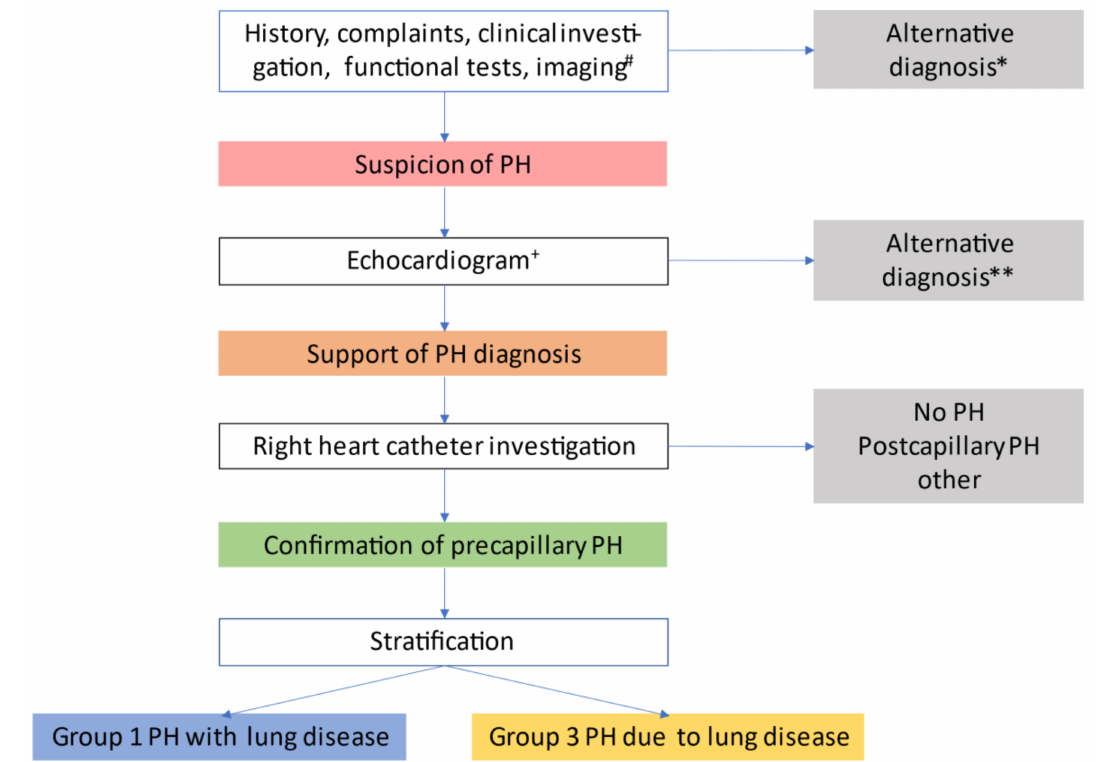
Figure 2. Evaluation of pulmonary hypertension in chronic lung disease. # suggestive findings include 1) symptoms and signs (dyspnoea out of proportion, loud P2, signs of right heart failure, right axis deviation on ECG, elevated natriuretic peptide levels); 2) pulmonary function test abnormalities e.g., DLCO < 40%, elevated %FVC/%DLCO-ratio (low KCO); 3) exercise test findings (including decreased distance, decreased arterial oxygen saturation or increased Borg rating on 6 min walk test and decreased circulatory reserve, preserved ventilatory reserve on cardiopulmonary exercise testing); and 4) imaging findings (extent of lung disease, enlarged pulmonary arterial trunk on chest x-ray, increased PA/AO-ratio on CT). *Uncontrolled systemic hypertension, bradycardia, arrhythmia, myocardial ischemia, obesity, thyroid disorder, depression, acute/subacute pulmonary embolism, exacerbation of lung disease. ** Systolic or severe diastolic myocardial failure, valvular heart disease, pericardial disease, congenital heart disease. + signs supporting the diagnosis of PH include elevated SPAP and signs of right ventricular dysfunction. Signs supporting the diagnosis of severe PH include reduced TAPSE/SPAP-ratio [59]. Adapted from Nathan et al.